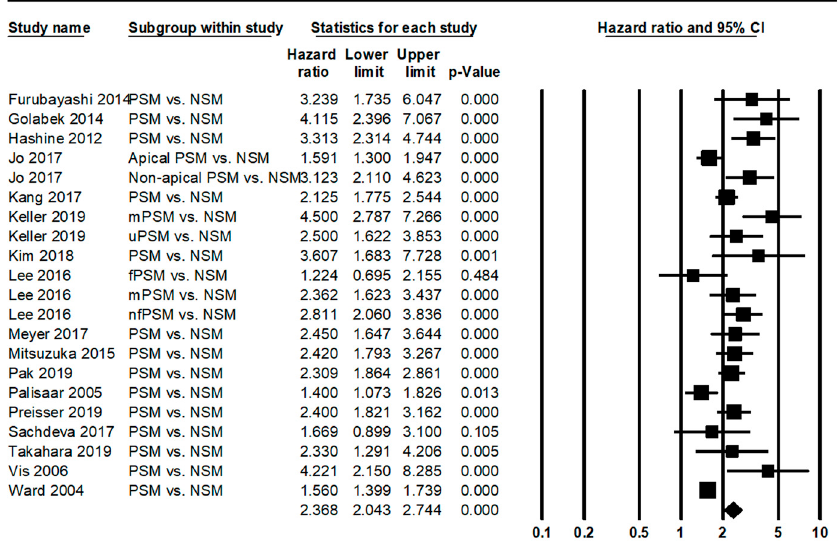
Figure 2. Forest plot for BCR-free survival between PSM and NSM (PSM: positive surgical margin; NSM: negative surgical margin; mPSM: multifocal PSM; uPSM: unifocal PSM; fPSM: focal PSM; nfPSM: non-single focal PSM).